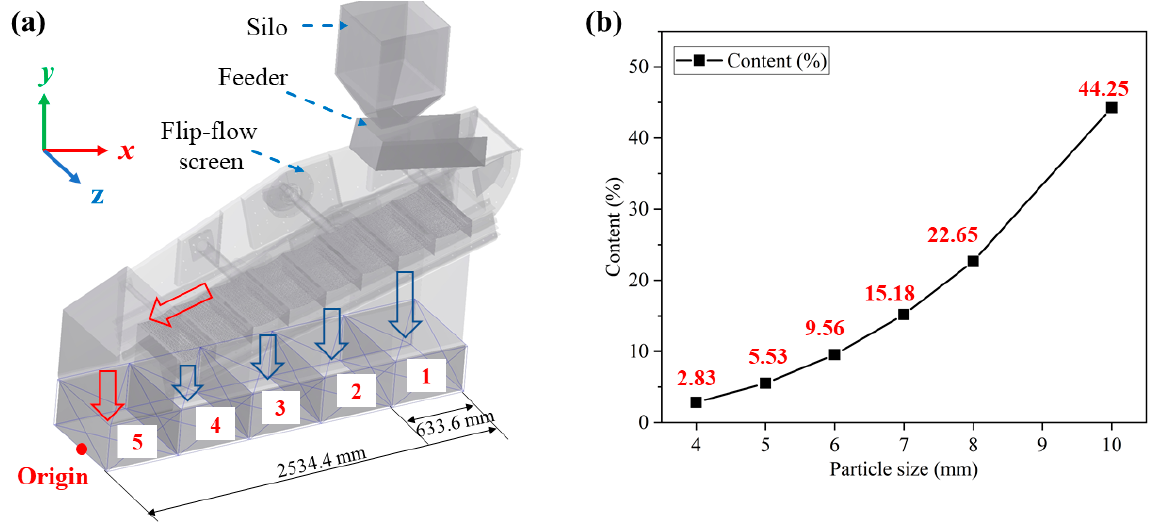
Figure 6. ( a ) Schematic of the DEM model of the VFFS system; ( b ) material properties of the sample. Table 2. Modeling condition in EDEM.